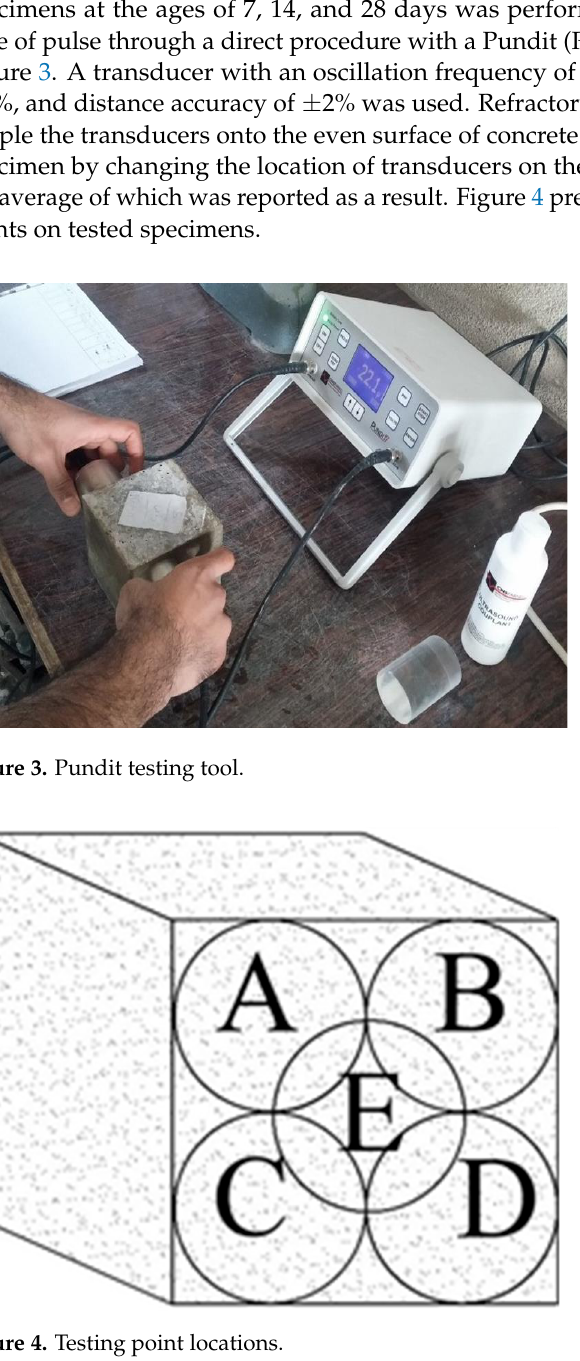
Figure 4. Testing point locations .